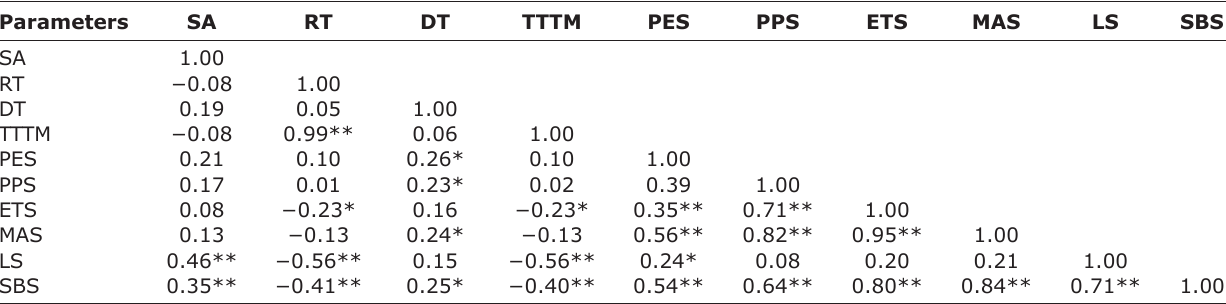
Table-1: Correlation matrix showing coefficients of correlation among sexual behavior parameters of adult Sahiwal bulls. Parameters